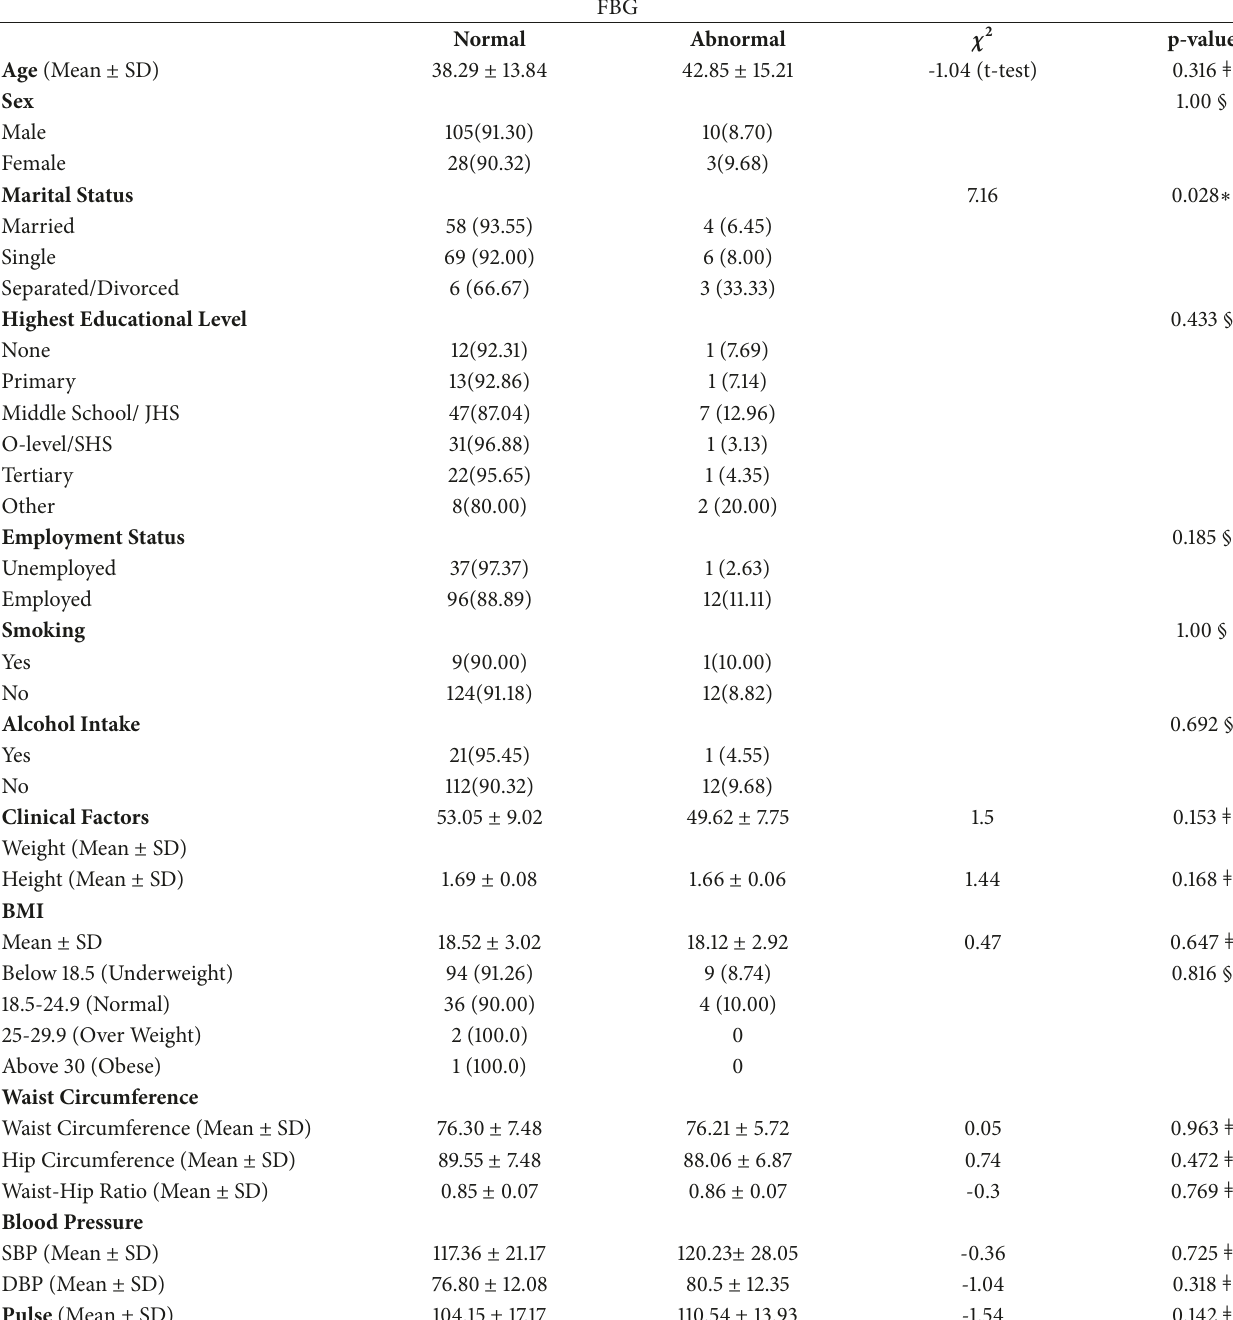
Table 3: Association between sociodemographic factors, clinical factors, and lifestyle factors and FPG